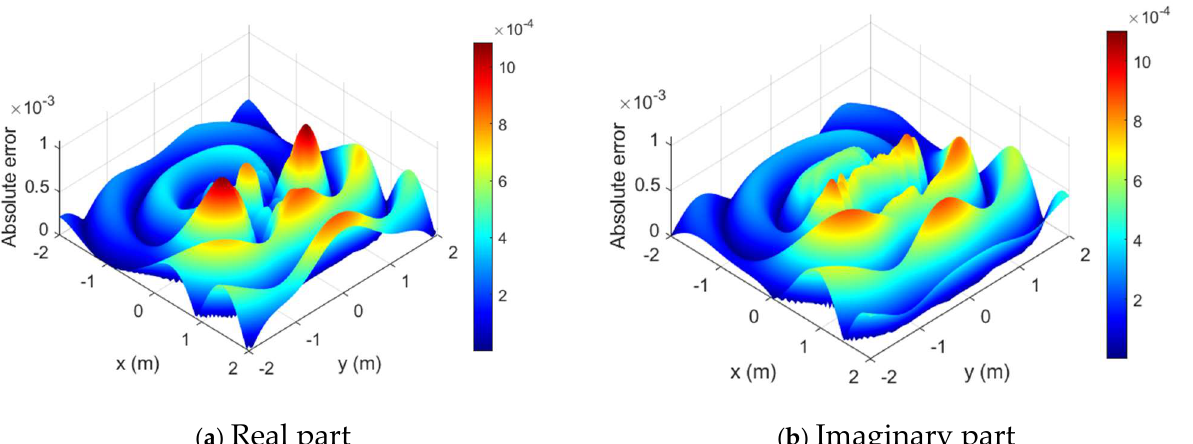
Figure 8. Distributions of absolute error in the domain [ − 2,2 ] × [ − 2,2 ] with regular nodes: ( a ) the real part with ( b ) the imaginary part.